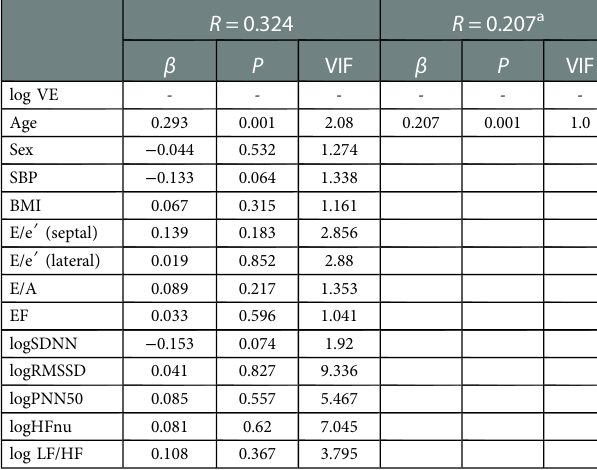
TABLE 5 Multiple regression analysis for log ventricular ectopy ( n =365). R =